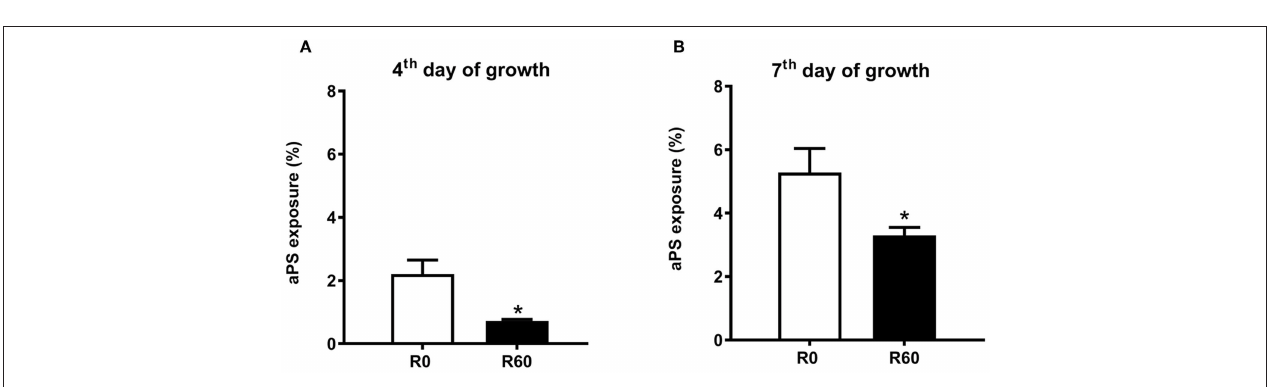
FIGURE 6 | aPs exposure by R0 and R60 promastigotes. (A) Profile of promastigotes grown for 4 days. (B) Profile of promastigotes grown for 7 days. 2 × 10 5 parasites from R0 and R60 were washed with PBS, suspended in binding buffer (BD-Anexin V-PE), and then incubated at room temperature for 15 min. At the moment of acquisition, 7AAD (PerCP-Cy5.5-A) was added as viability control, following manufacturer instructions. Data is shown as the difference between the geometric mean of the fluorescence intensity of unstained control samples ( Supplemental Figure 5 —Q1) compared to annexin V(PE) stained ones ( Supplemental Figure 5 —Q4). Viability was checked by 7AAD (PerCP-Cy5.5-A) parasites labeled ( Supplemental Figure 5 —Q2 and Q3). Data were collected in BD Fortessa and analyzed by FlowJo-X. At least 10,000 gated events were collected from each sample, in triplicates, from two essays. * p ≤ 0.05 Two-Way ANOVA.